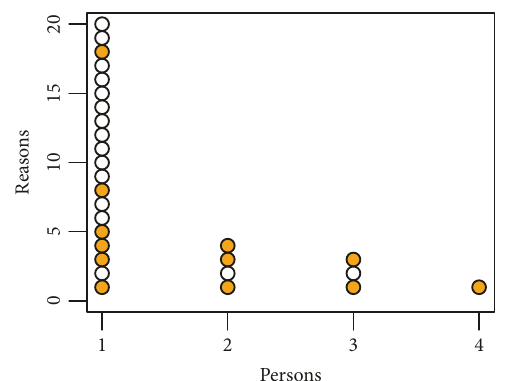
Figure 2: The reason space consists of reasons and the number of individuals that hold those reasons. Wepresenta random individual who acknowledges reasons # 1 , # 3 , # 4 , # 5 , # 8 , and # 18 , which are held by 4 , 3 , 2 , 1 , 1 , and 1 persons, respectively. The person–reasons covered by this person are shown in orange and represent this individual’s representativeness, 𝜌 = 4 + 3 + 2 + 1 + 1 + 1 = 12